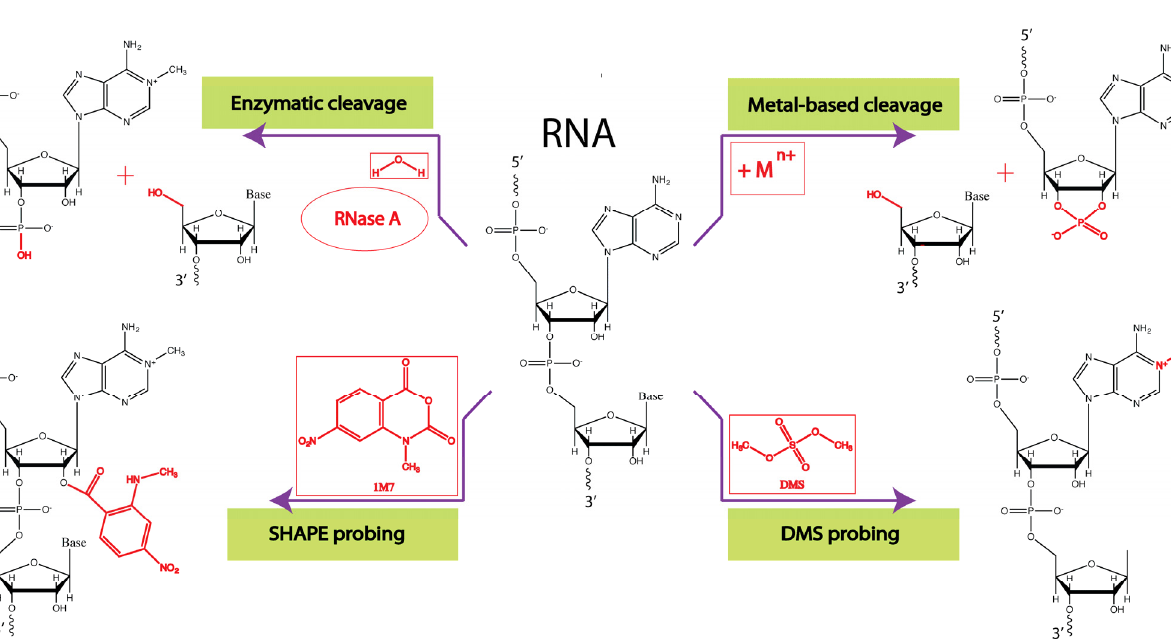
Figure 2. Mechanistic examples of enzymatic and chemical probing of RNA